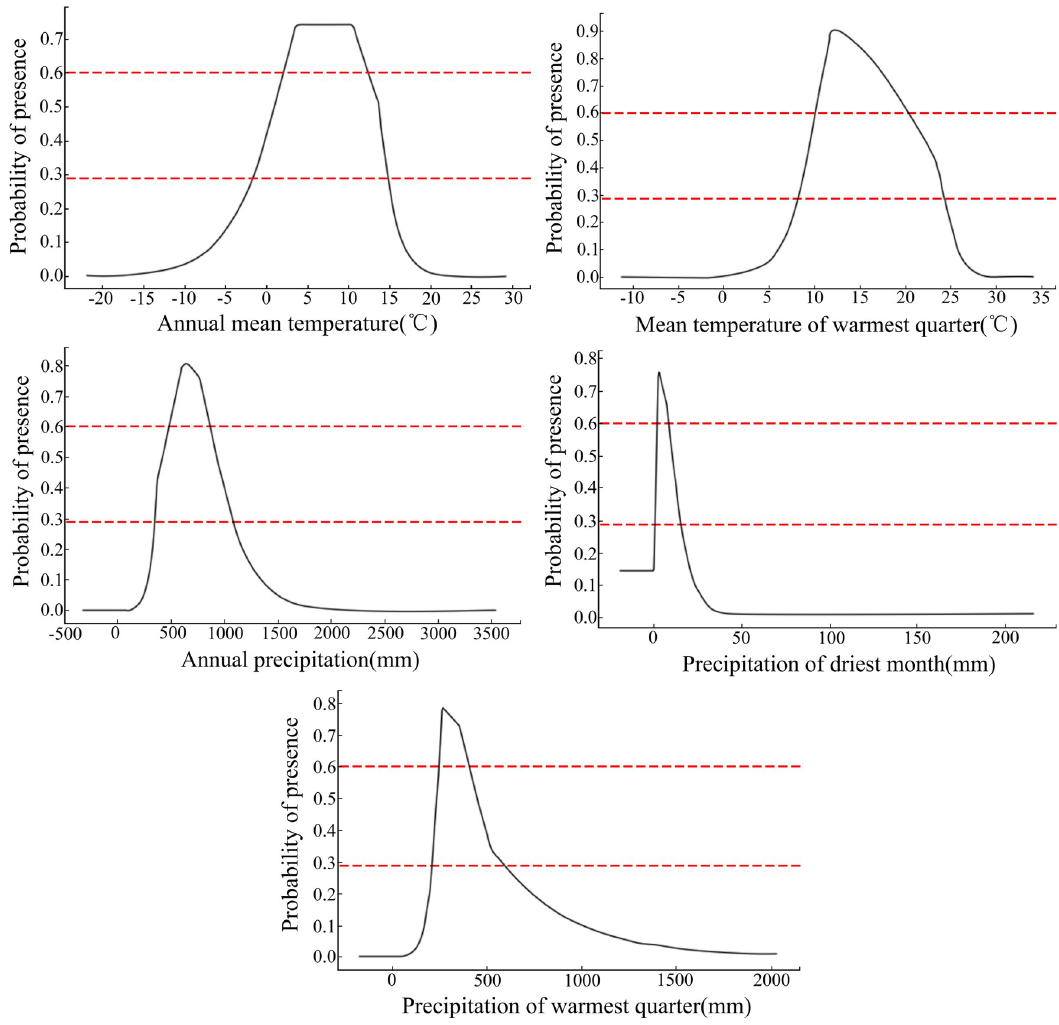
Fig 3. Response curve of the dominant environmental